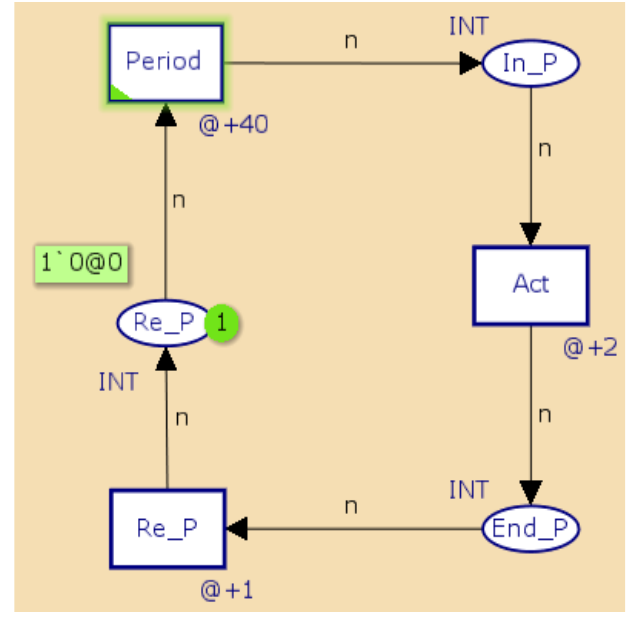
Figure 3. Representation in CPN of a periodic component.